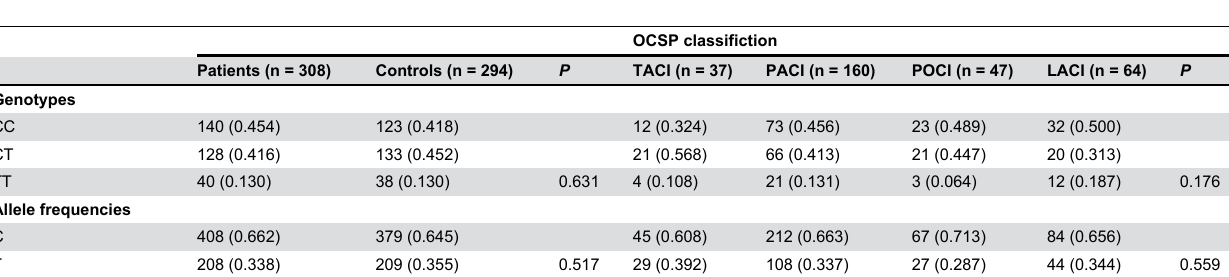
Chi-square test was used to compare values of all